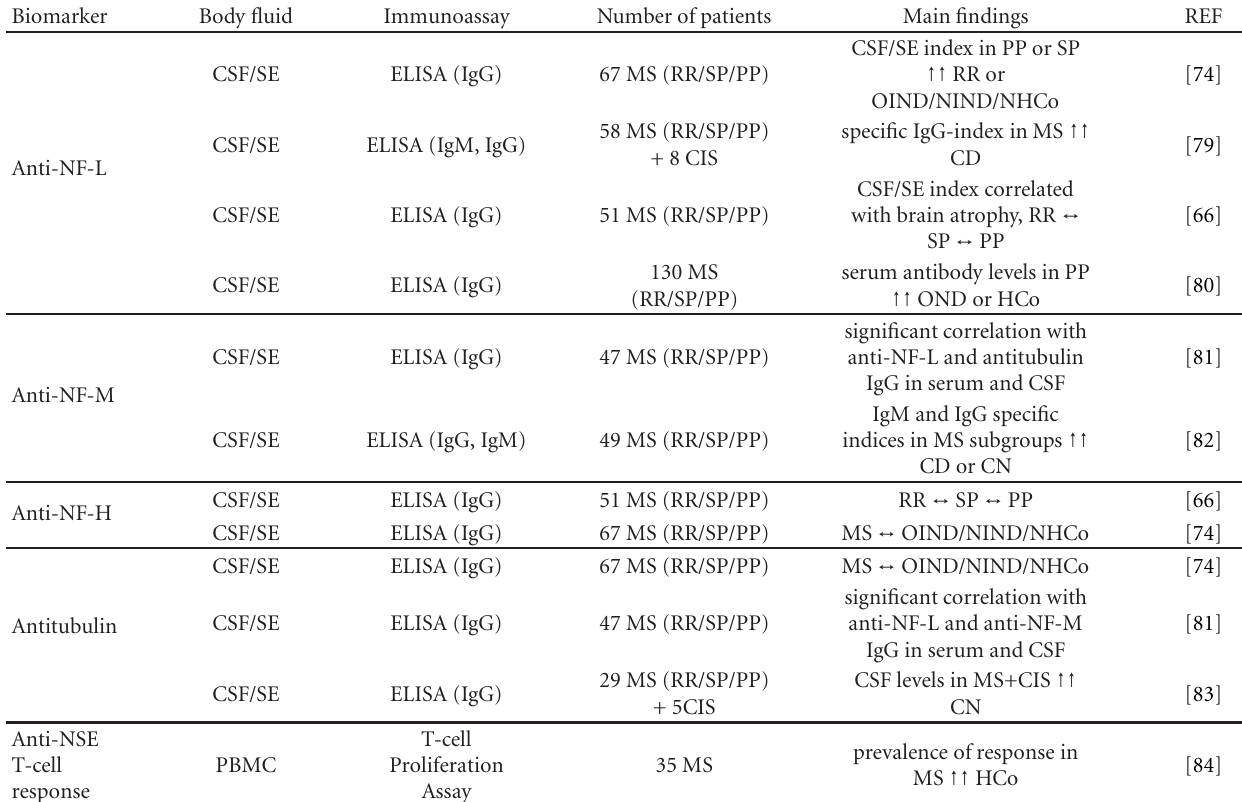
Table 3: Parameters of humoral and cellular response to markers of neuroaxonal damage in the cerebrospinal fluid (CSF) and blood of patients with multiple sclerosis (MS) and clinically isolated syndrome suggestive of MS